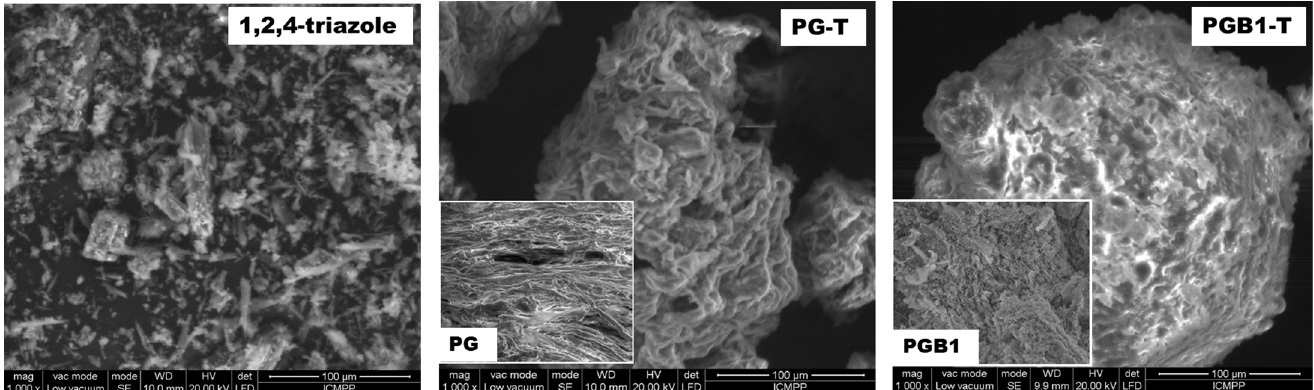
Figure 10. XRD patterns of 1,2,4-triazole, PG-T, and PGB1-T systems ( a ) and of PG and PGB1 copolymers ( b ) .